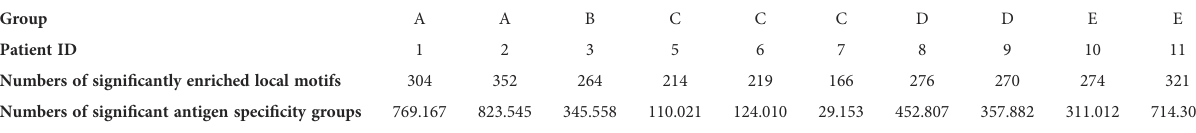
TABLE 3 TCR clustering characteristics in the CD8 + T cell